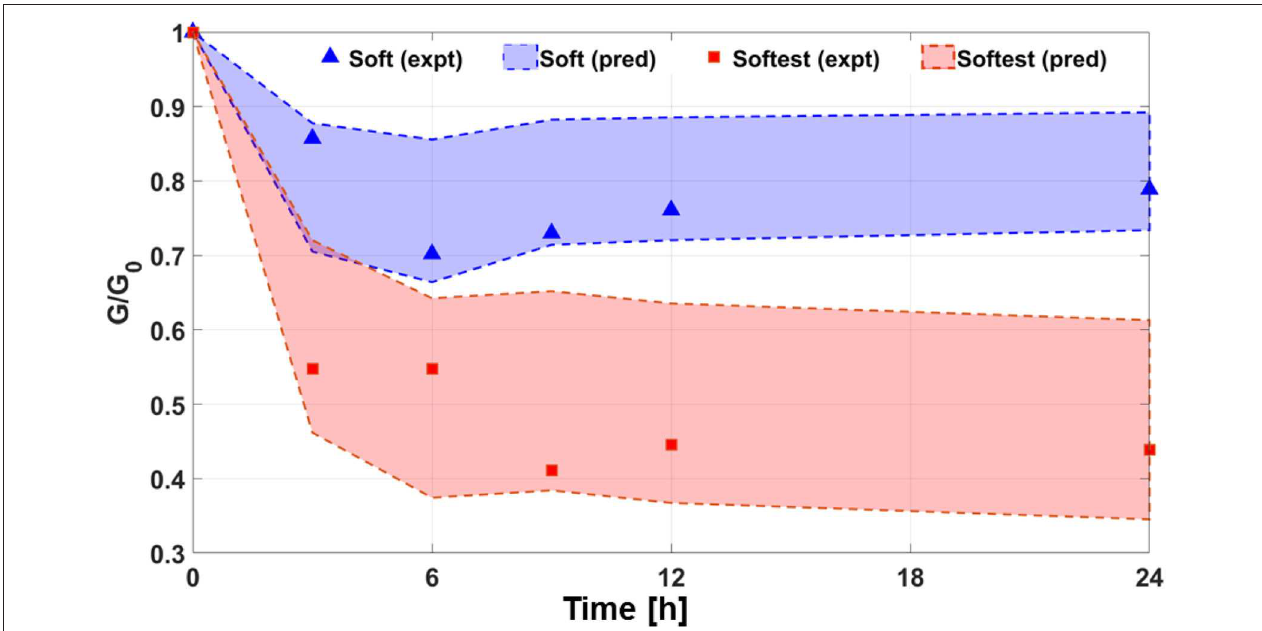
FIGURE 6 | Changes in relative shear modulus as a function of swelling time for soft and softest gels for short-term swelling experiments (up to 24h). Filled symbols are obtained from AFM measurements of G (c) and G 0 . Dashed lines bounding the shaded regions correspond to the bounds of G (u) predicted by Equation 5, and normalized by the AFM measurements of G 0